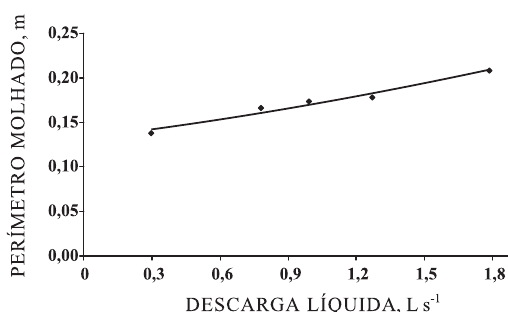
repetições.Figura 4. Relação entre a descarga líquida e o perímetro molhado na erosão em sulcos. Média de cinco